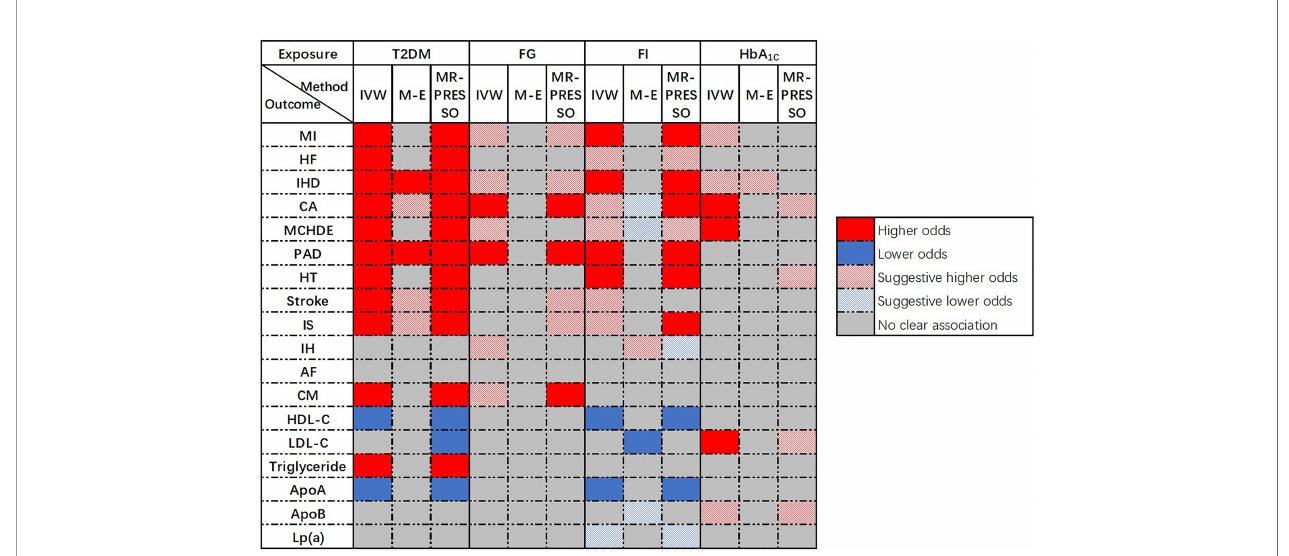
FIGURE 2 | Overview of the main results of Univariable